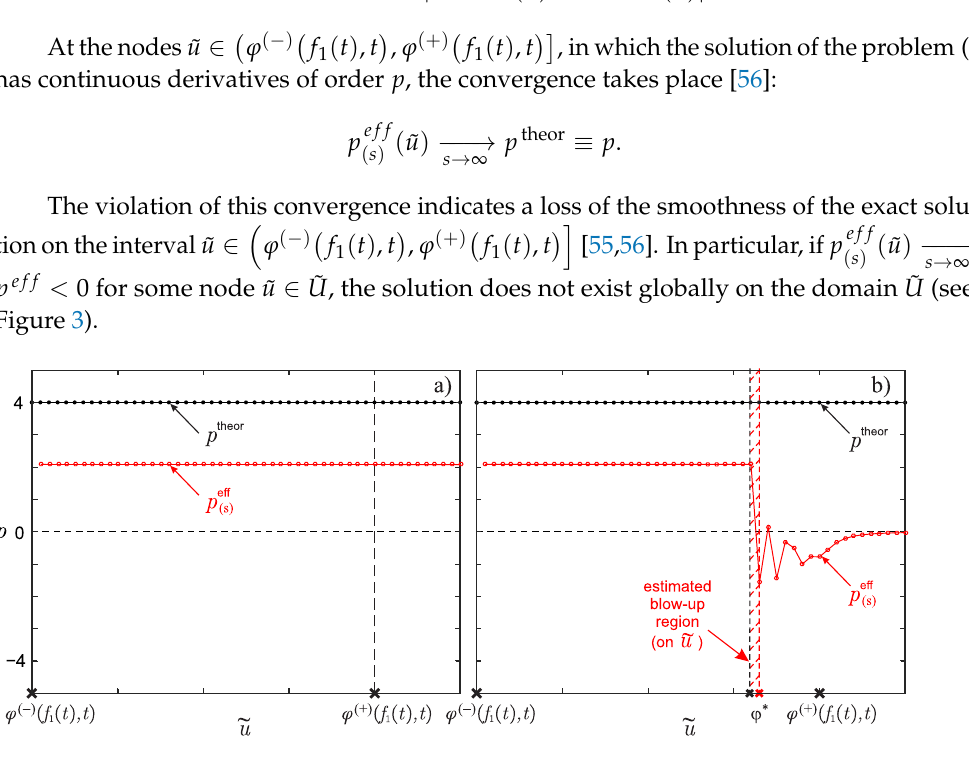
( ˜ u ) , which correspond to the solutions of the Cauchy Figure 3. Typical form of the functions p ef f ( s ) problems shown in Figure 2. Subfigures ( a , b ) correspond to the subfigures in Figure